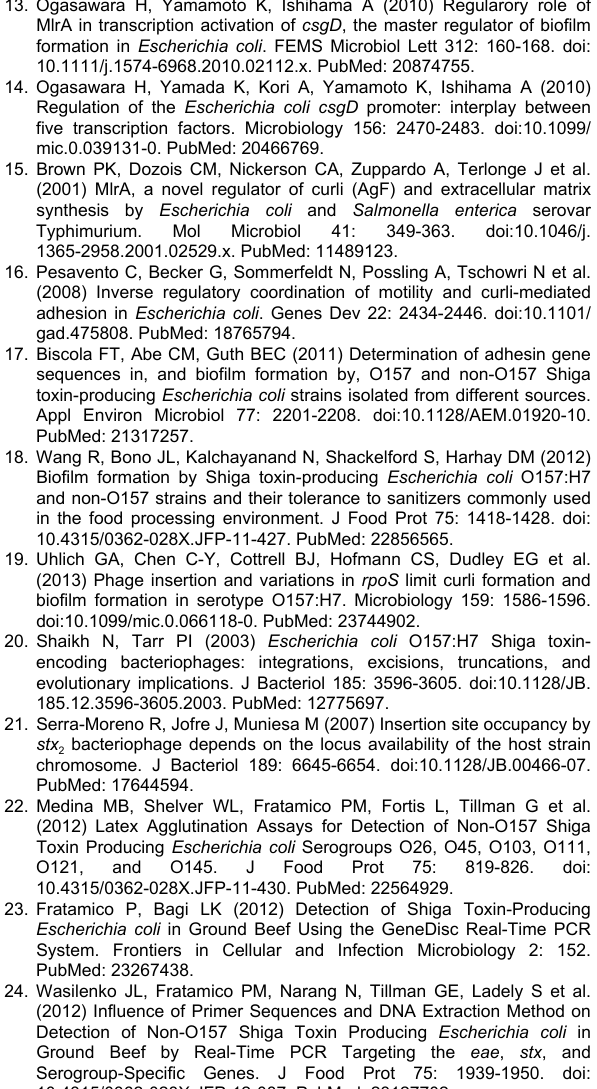
Figure S1. PCR characterization of stx , stx , and mlrA 1 2 genes. (A) stx , (B/C) stx , and (D) mlrA multiplex PCR. 1 2 Ladder: 1kb Extension ladders (A-C) or 100-bp DNA